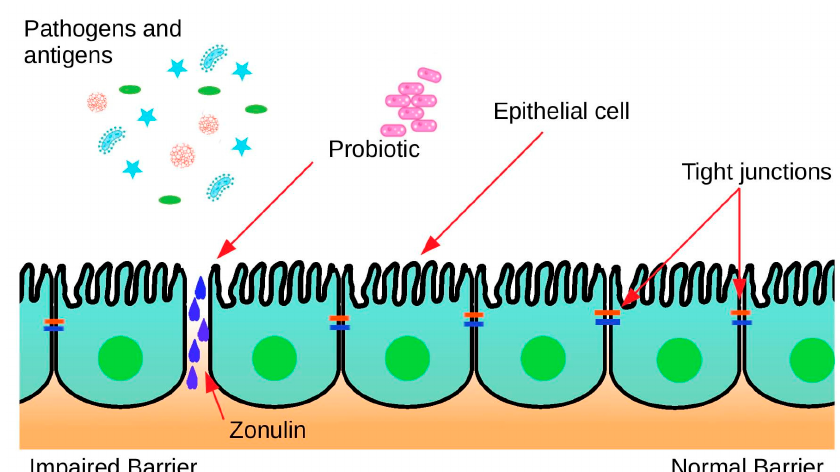
Figure 2. Decreased intestinal permeability.